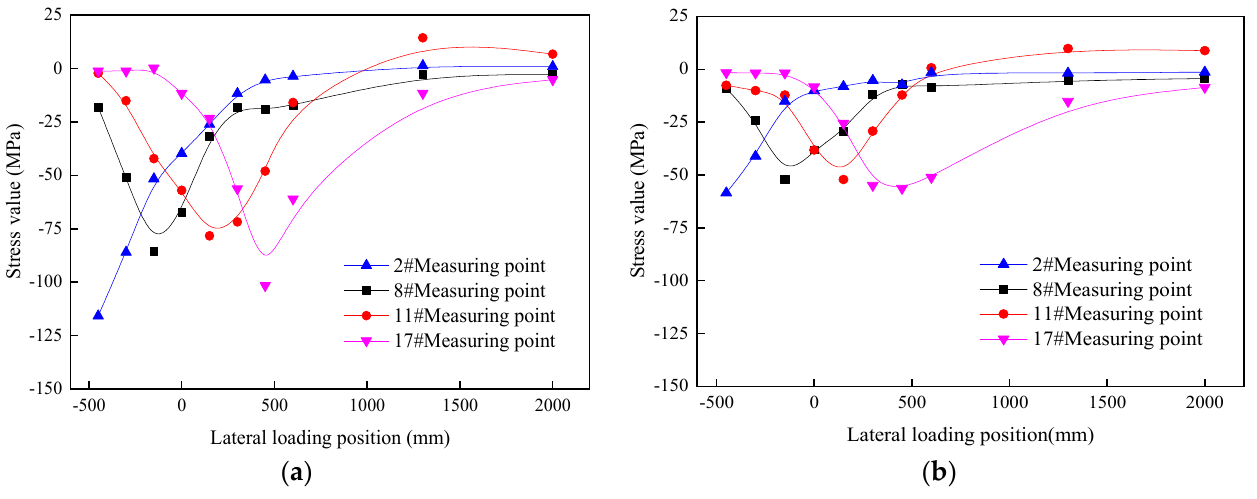
Figure 18. Transverse loading 105# diaphragm (notch optimization) CI area measuring point stress-load position relationship curve: ( a ) Before optimization, ( b ) after optimization.